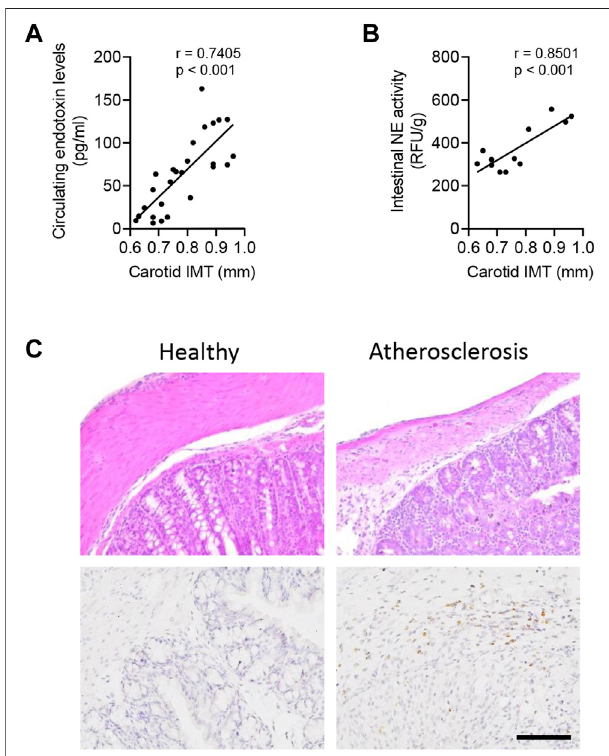
FIGURE 6 | Intestinal NE level is closely associated with the human atherosclerotic status. In total, 26 volunteers were recruited, including 12 patientswithintestinalpolypsurgery. (A) Correlationbetweencirculatinglevels of endotoxin and carotid intima-medial thickness (IMT). (B) Measurement of intestinal NE activity in 12 patients with intestinal polyp surgery and further correlation of the intestinal NE activity and carotid IMT. (C) HE staining and immunohistological staining of NE in human